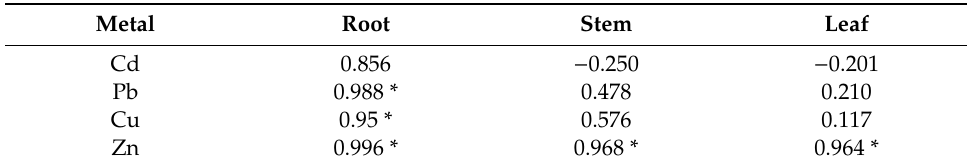
Table 1. Correlation coe ffi cients ( r ) between heavy metal concentrations in the soil and heavy metal concentrations in the plant